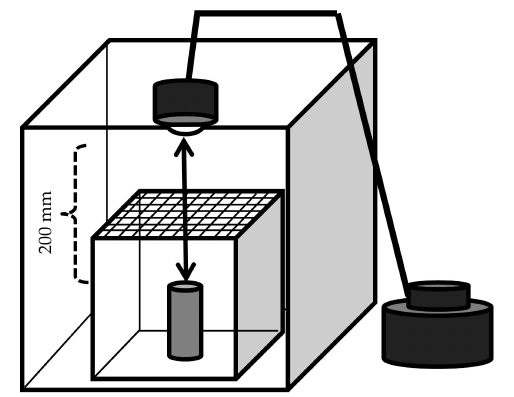
Figure 2. Experimental device for the detection of the influence of temperature and luminous intensity on the calling behavior of Rosalia batesi males. A corrugated cardboard box (400 × 400 × 400 mm) was prepared, in which a glass chamber (150 × 150 × 150 mm, with a nylon mesh on top) containing a perpendicular Zelkova serrata bolt (80 mm long, 40 mm in diameter) was installed. An incandescent lamp was attached to the ceiling of the cardboard box (200 mm from the bolt top). The incandescent lamp was powered with three different voltages (100, 50, and 30 V) to achieve three temperature and luminous intensity regimes (high, medium, and low, respectively). The test animal ( Rosalia batesi male) was released near the